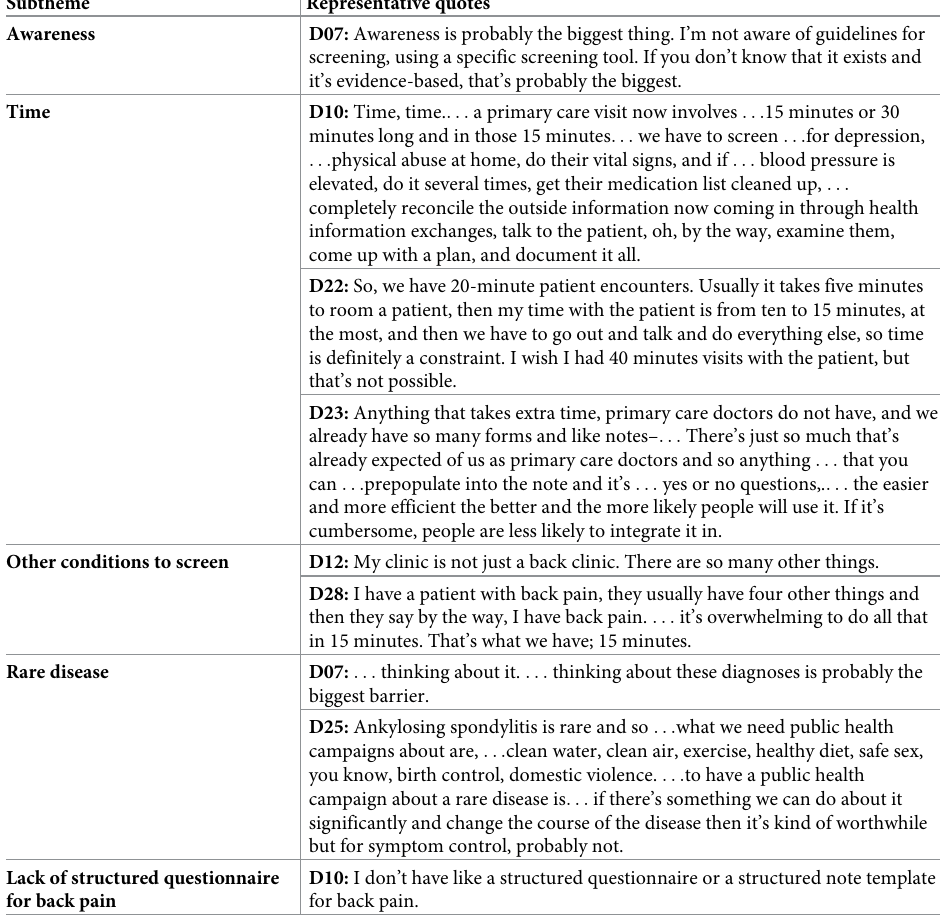
Table 5. Primary care physician perceptions of perceived barriers to implement the screening tool for axial